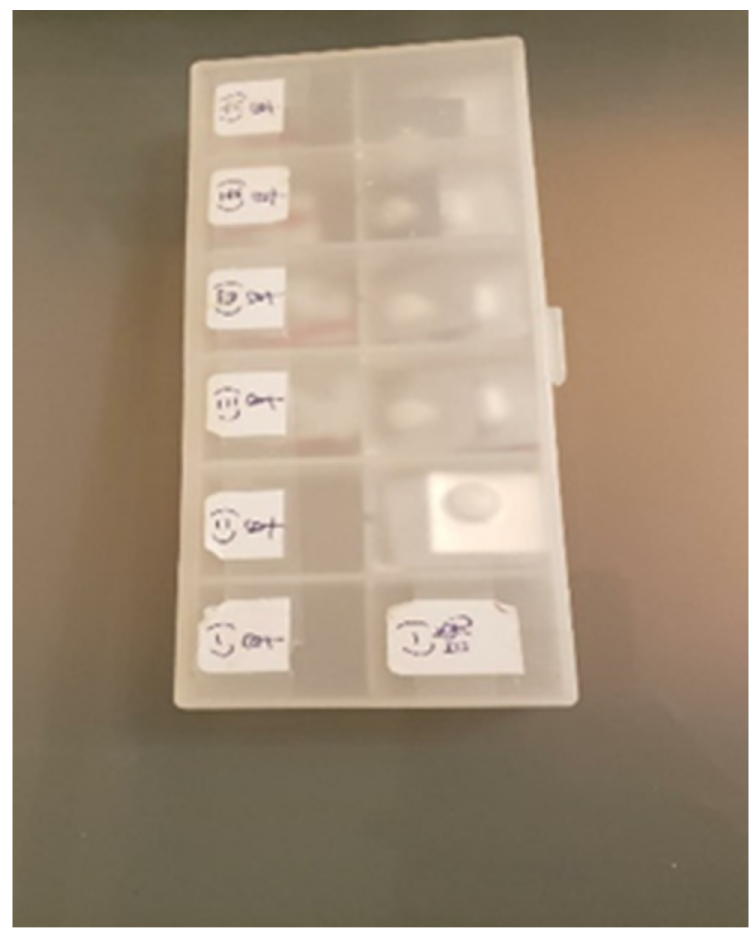
Figure 11. Photograph by Participant L. The marks on the pill box are Monday to Saturday, morning and night.